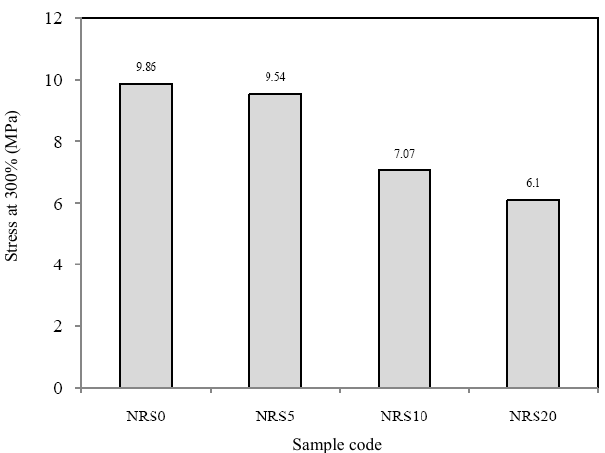
Figure 7. Stress at 300% of samples at various silica ratios.